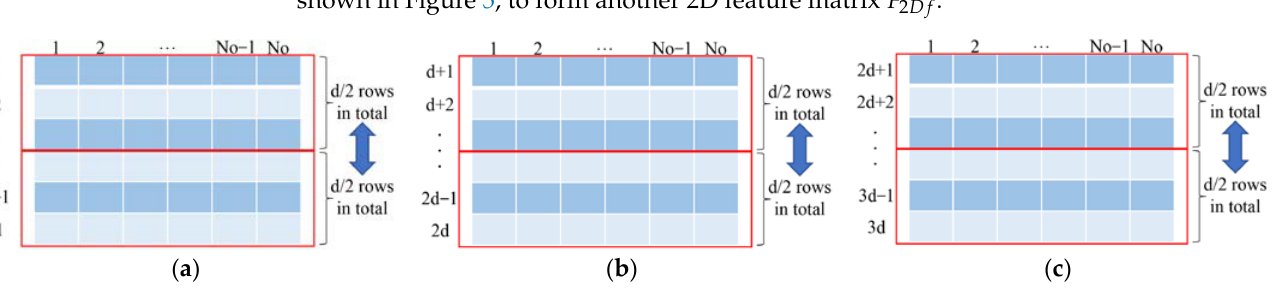
Figure 5. The 2D matrix processing of the sensed image: ( a ) rows 1 to d ; ( b ) rows d + 1 to 2 d ; and ( c ) rows 2 d + 1 to 3 d